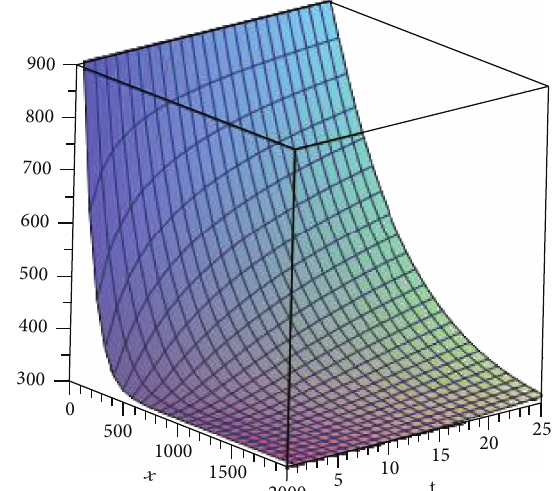
and numerical Approx Figure 12: Approximate analytic solution 𝑇(𝑥,𝑡) of the IBVP (42) and